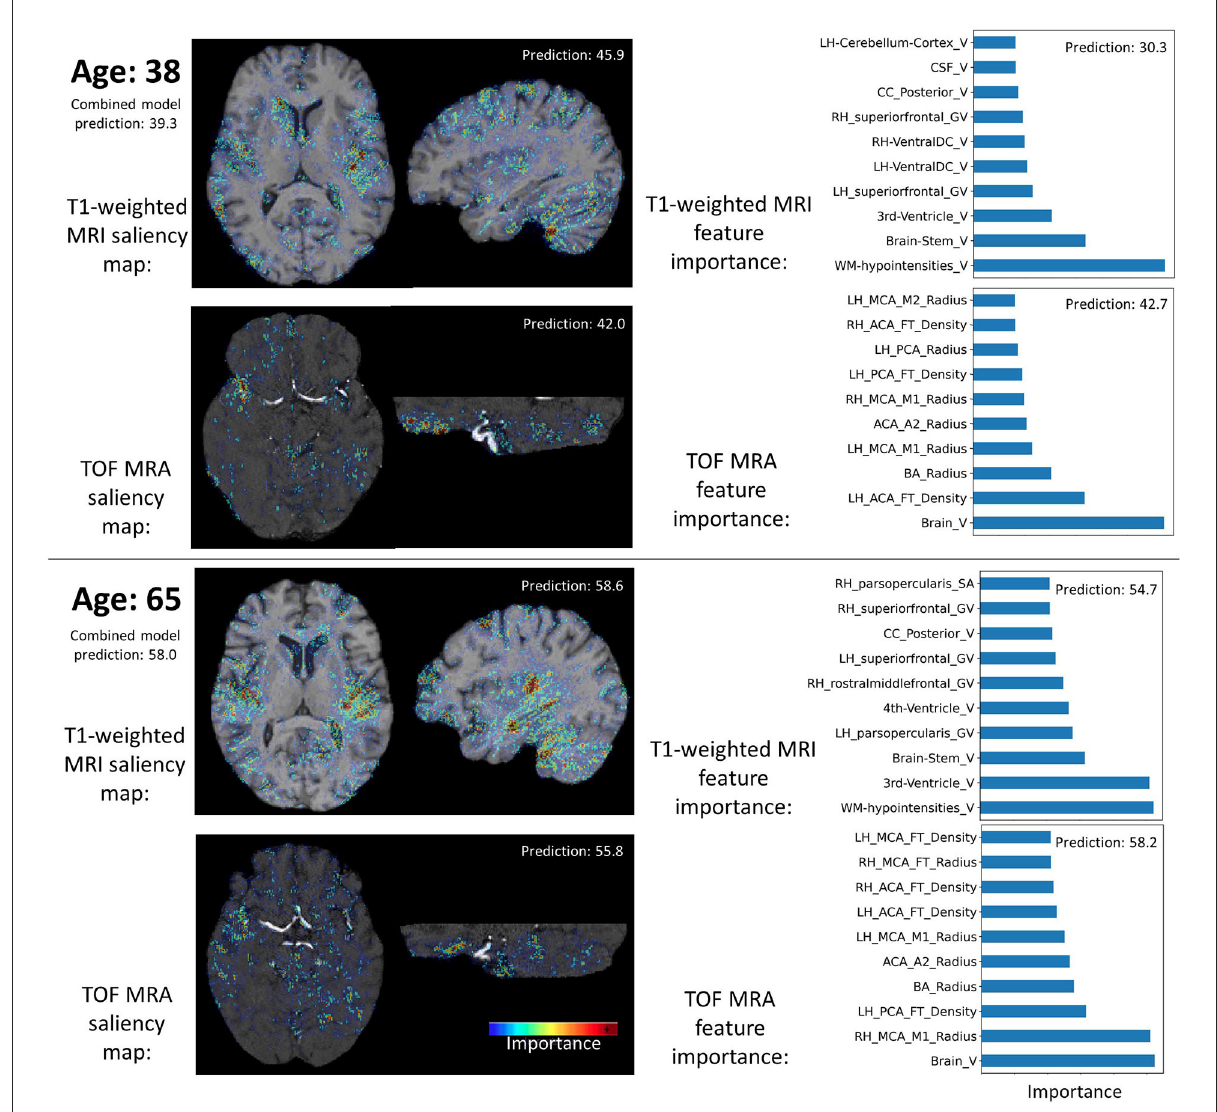
FIGURE4 Examples of input data importance (axial and sagittal views of saliency maps for the CNN models and feature importance for the MLP models) for two participants. Brain age predictions of the combined and individual models are indicated. RH, Right hemisphere; LH, Left hemisphere; PCA, Posterior cerebral arteries; MCA, Middle cerebral artery; BA, Basilar artery; ICA, Internal carotid artery; FT, Flow territory; V, Volume; GV, Gray volume; TA, Thickness